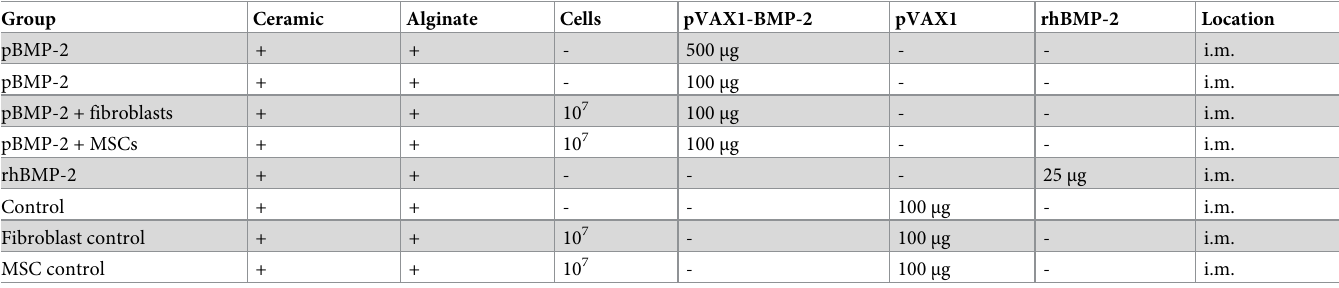
Table 2. Experimental groups used to assess osteogenicity of plasmid based expression of pBMP-2 (eight weeks in rats). Group Ceramic Alginate